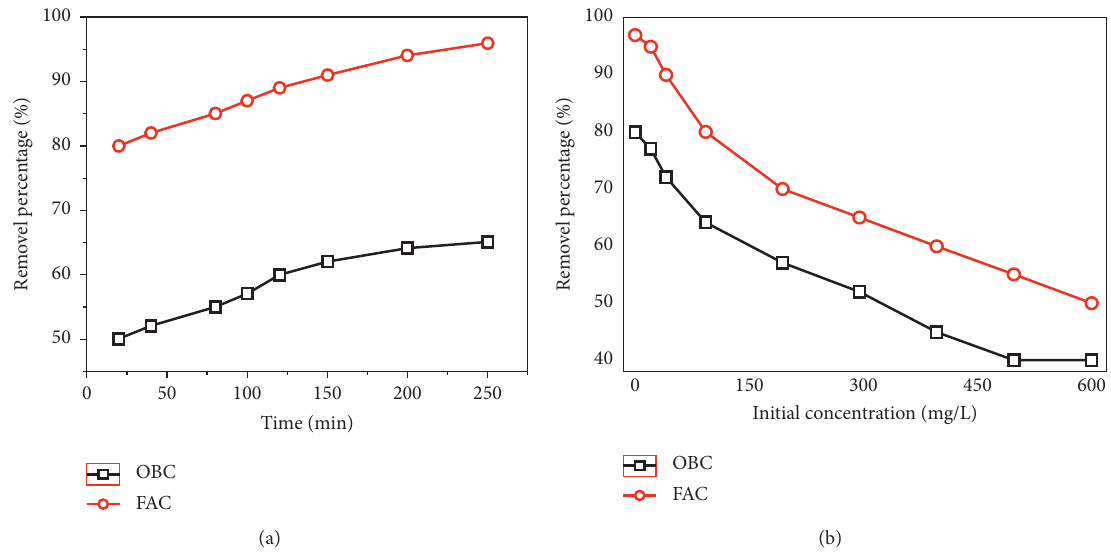
Figure 4: Effect of (a) contact time and (b) initial concentration on the As(V) adsorption by OBC and